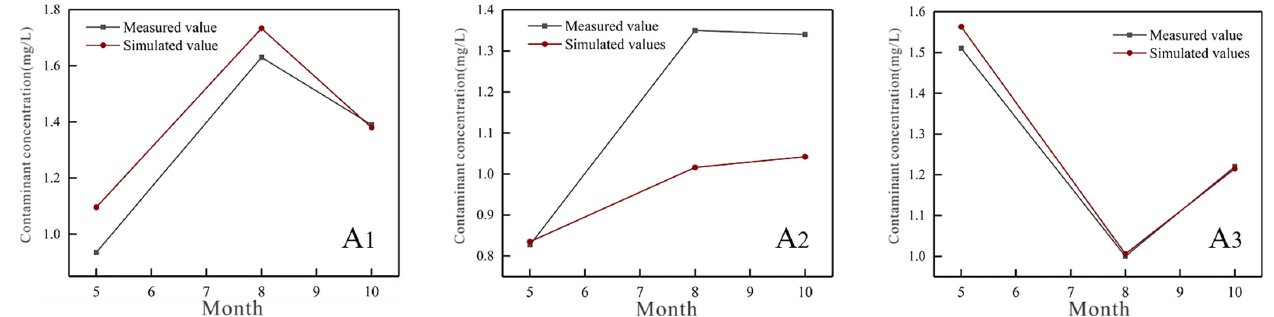
Figure 5. Illustration of Liaodong Bay’s water quality measuring locations.